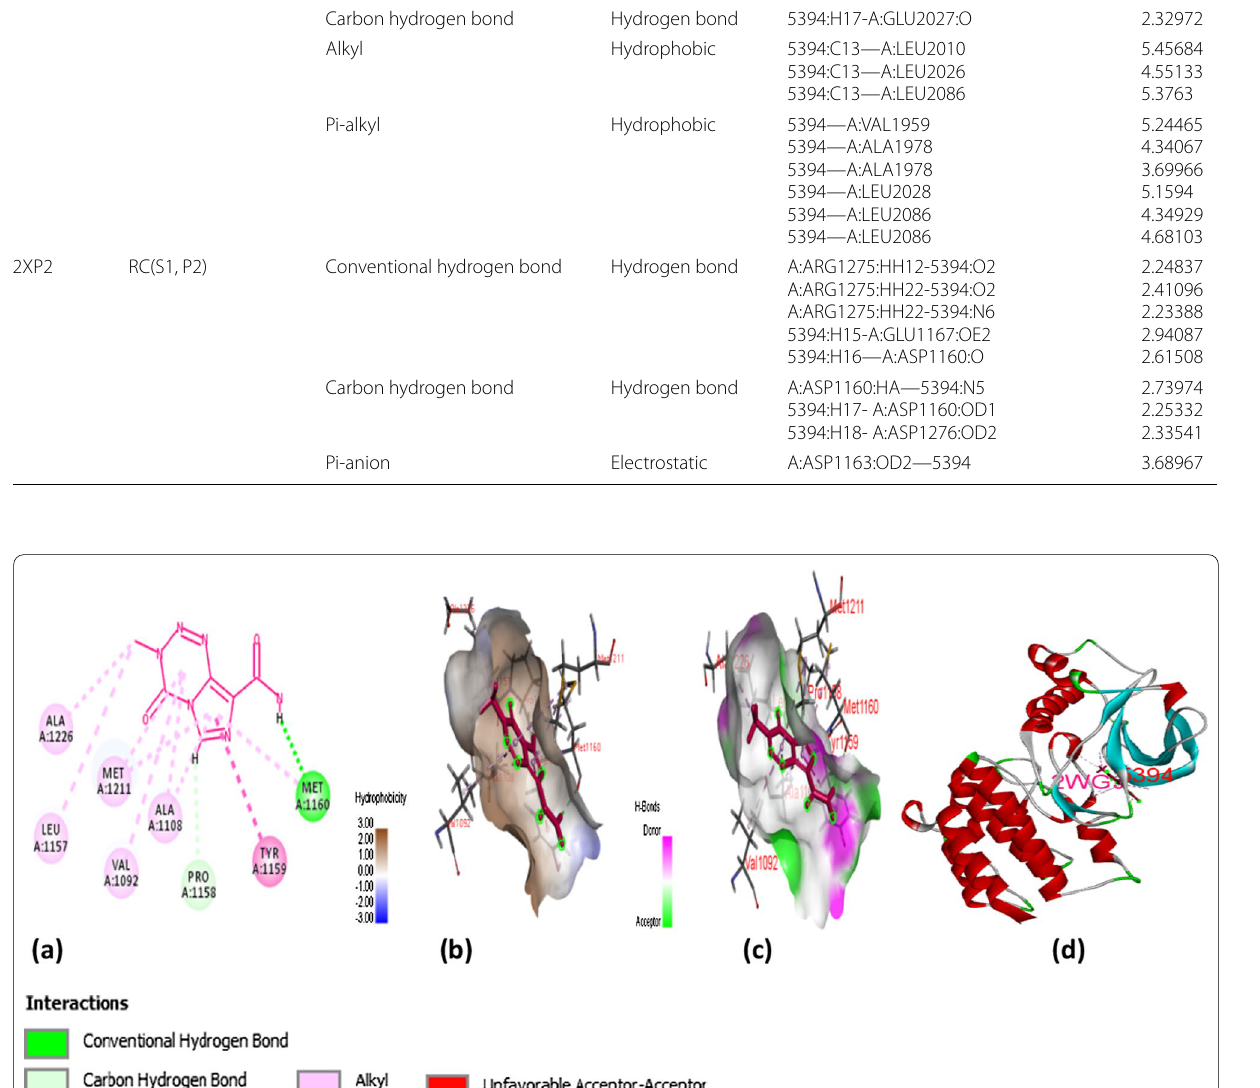
Table 9 Details of intermolecular interactions at the binding site of Temozolomide drug with proteins C-MET, C-ROS1 and ALK Protein Name